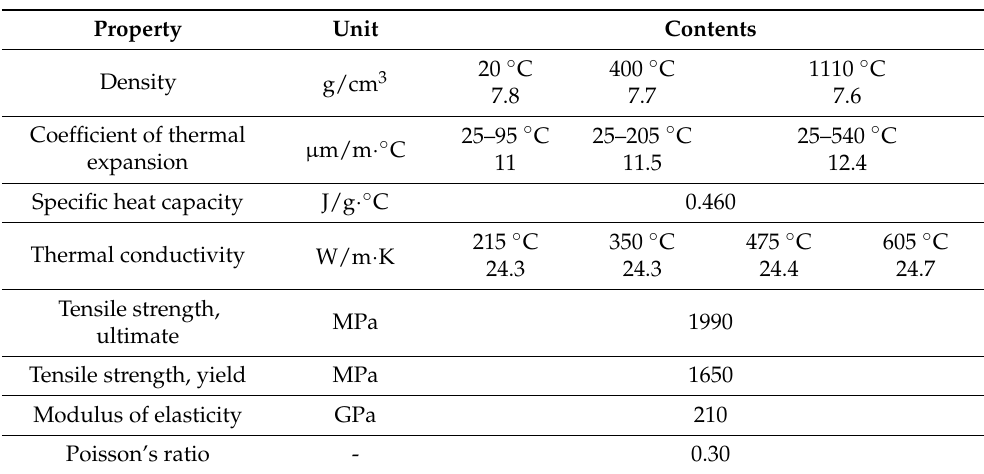
Table 3. Material properties of